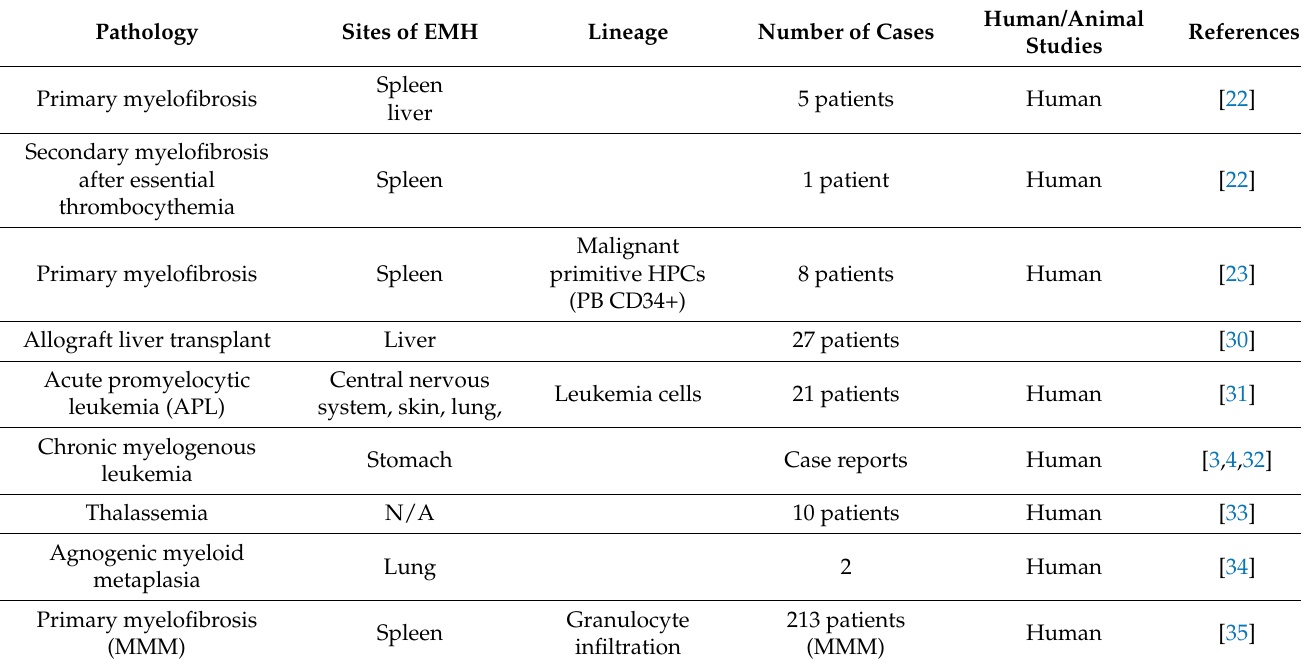
Table 1. Extramedullary hematopoiesis in clinical studies and experimental